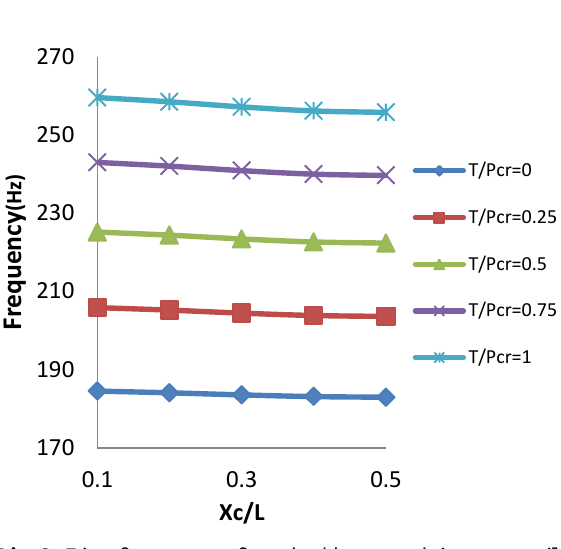
Fig. 3. First frequency of cracked beam, subject to tensile